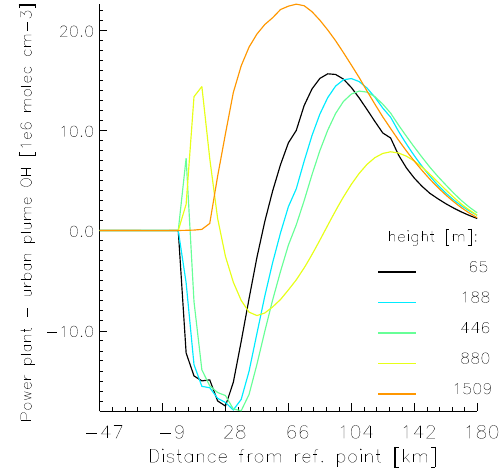
Fig. 17. Simulated absolute difference between the “power plant” and “urban area” plume ozone mixing ratio for the five CBL model levels as a function of the distance downwind of the eastern city limits of Manaus.